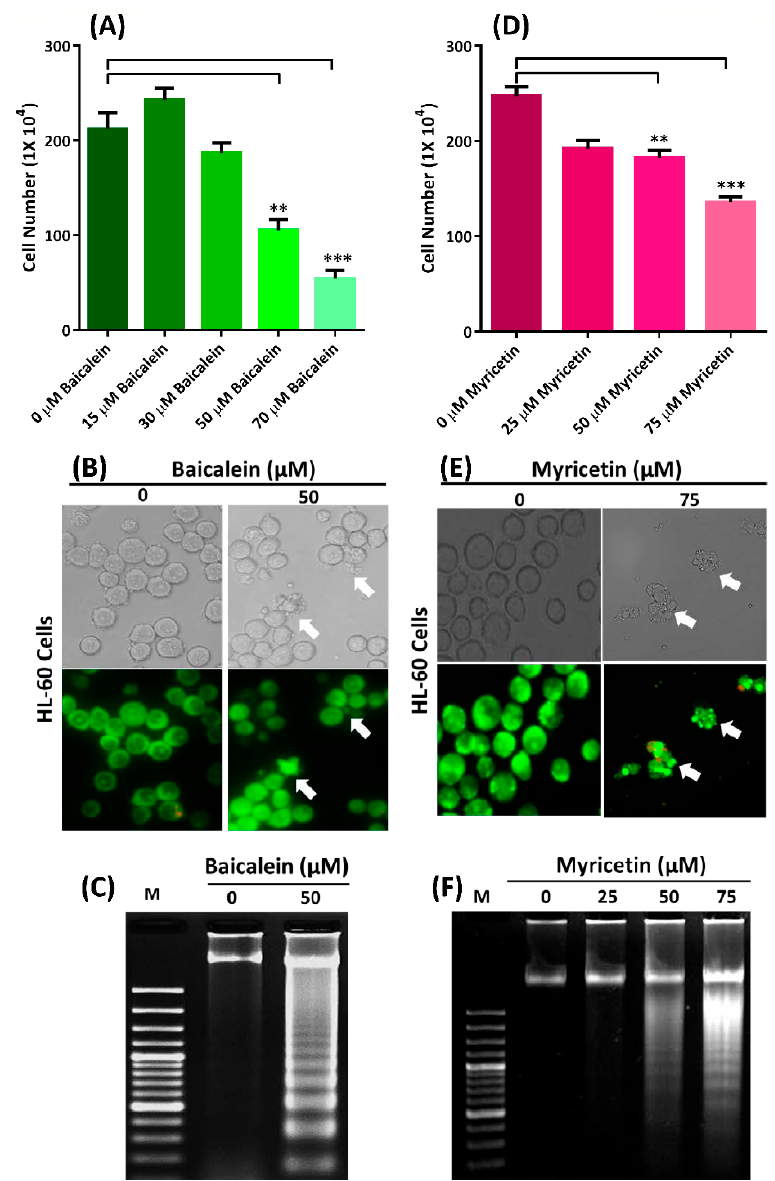
Figure 6. Baicalein and myricetin suppress cell growth and induce apoptosis of HL-60 cells. ( A , D ) Cell growth was suppressed in a dose-dependent manner with baicalein and myricetin, respectively. ** p < 0.01, *** p < 0.001 ( n = 3). ( B , E ) Apoptotic bodies (indicated by arrows) in the cells were present after treatment with 50 µM of baicalein and 75 µM myricetin, respectively. ( C , F ) DNA fragmentation in the cells after treatment with 50 µM baicalein and 0-75 µM myricetin.